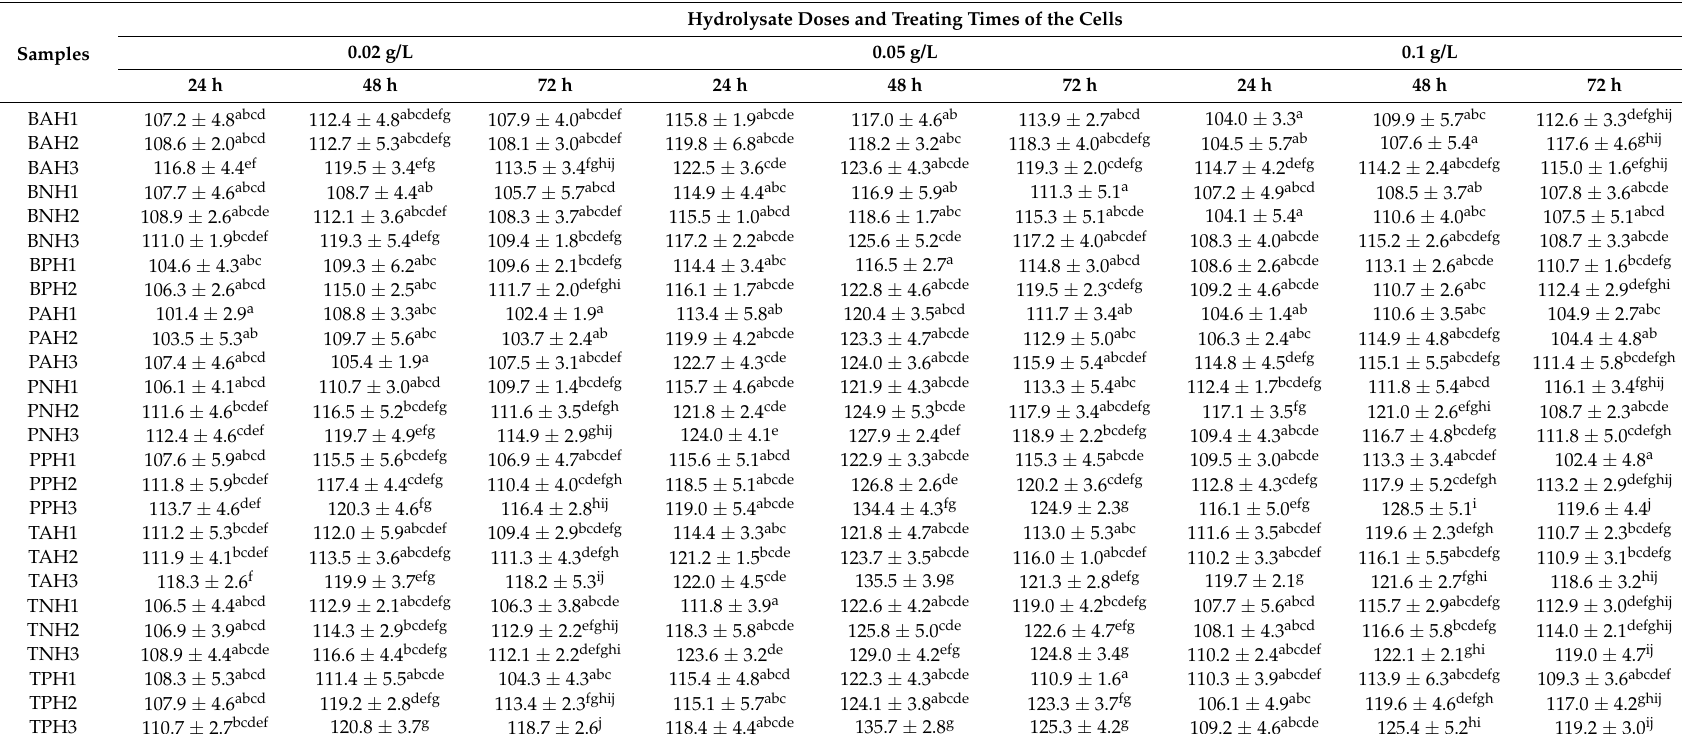
Table 2. Cell viability (%) of the osteoblasts treated with different hydrolysates for 24, 48 or 72 h.